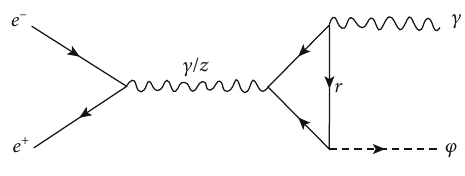
Figure 9: e + e − → γϕ triangle